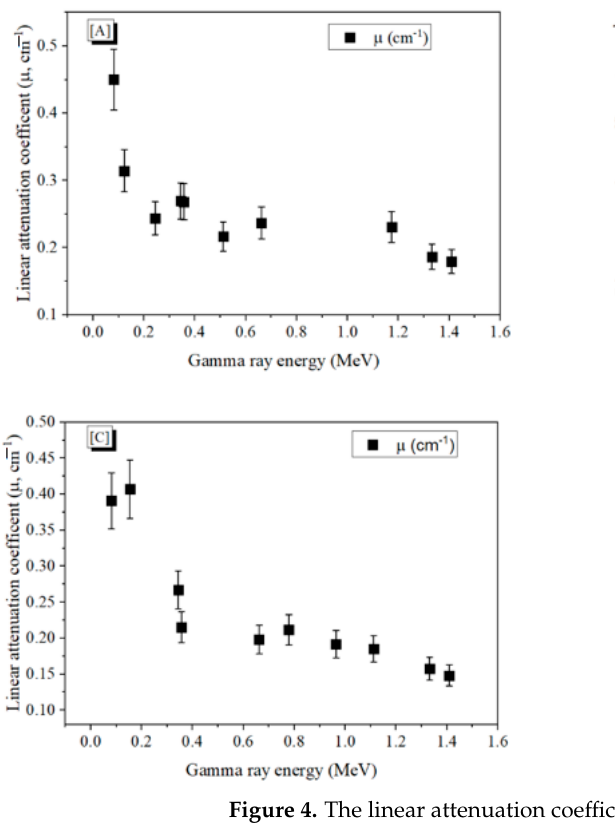
Figure 4. The linear attenuation coefficient versus the incident E γ for concretes coded ( A ), ( B ), and ( C ), respectively.